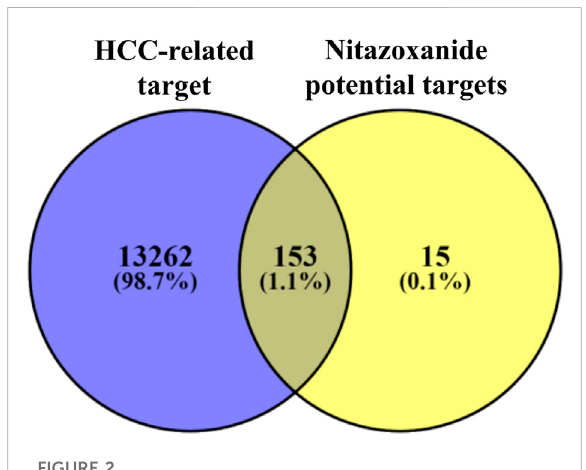
FIGURE 2 The intersecting targets between HCC-related and potential targets of nitazoxanide (HCC = Hepatocellular